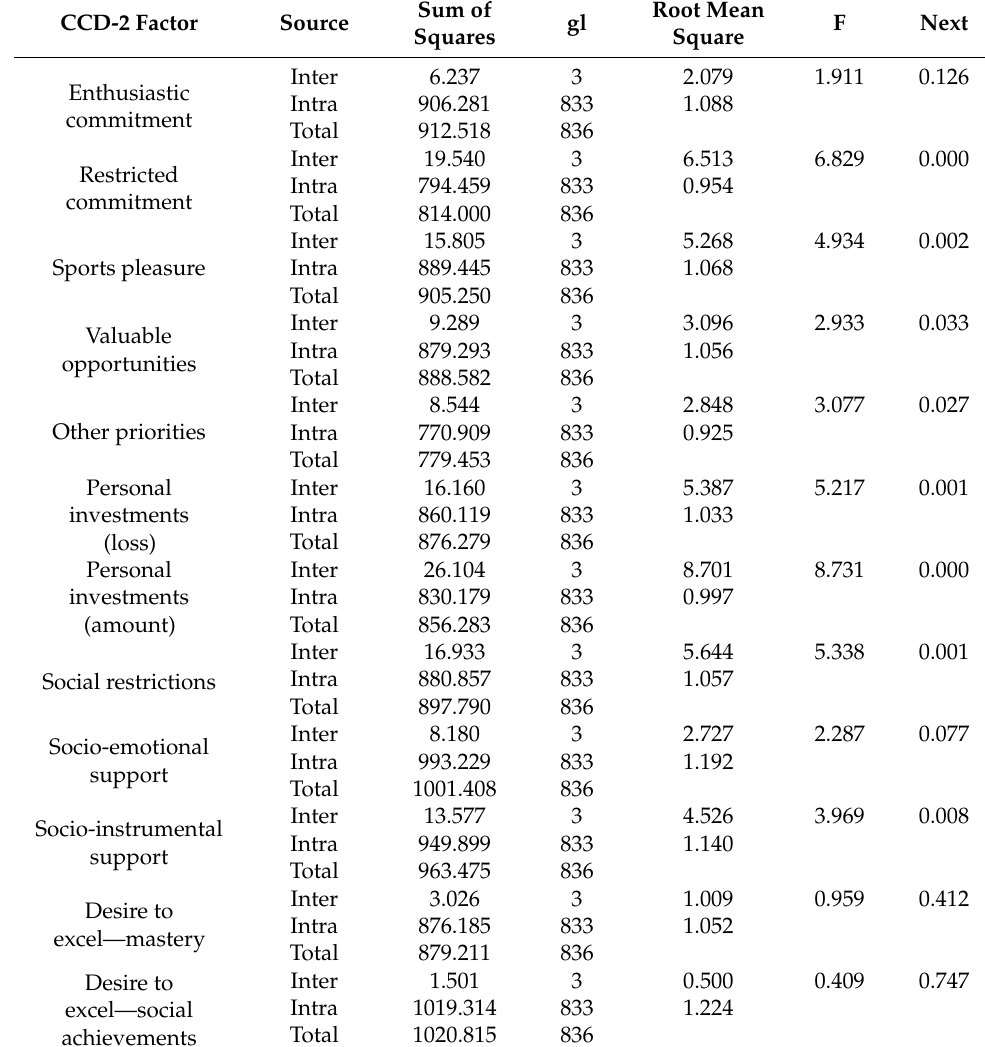
Table 3. Summary of intra–inter subjects univariate ANOVA (assuming equal